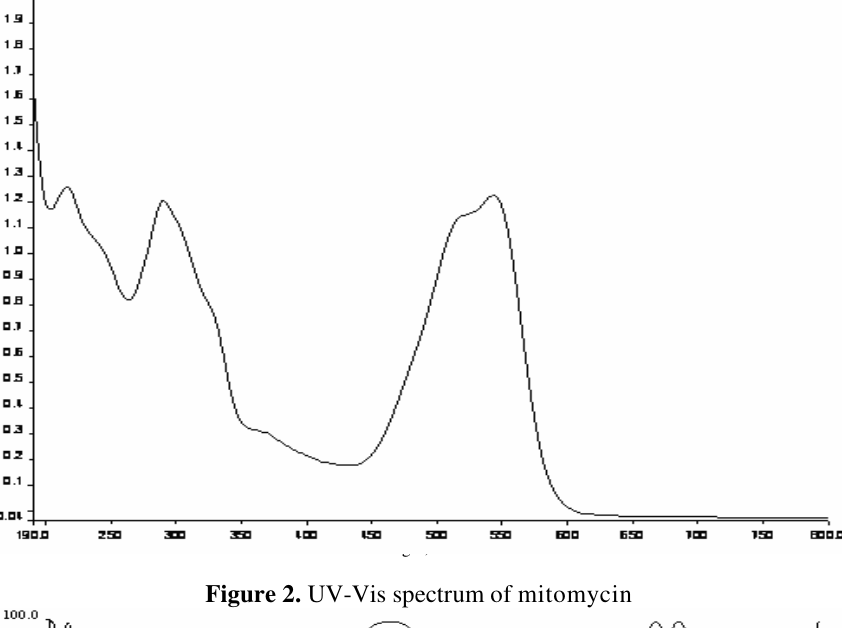
Figure 2. UV-Vis spectrum of mitomycin